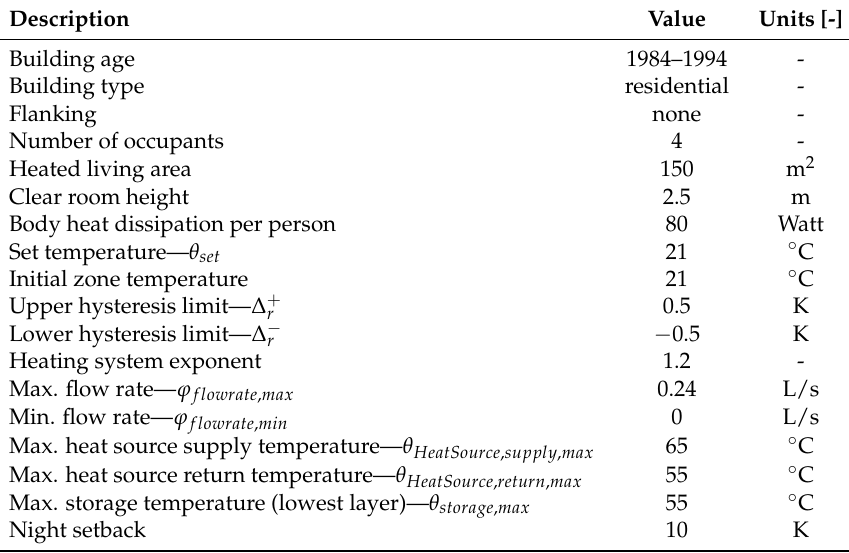
Table 1. Building and control models basic